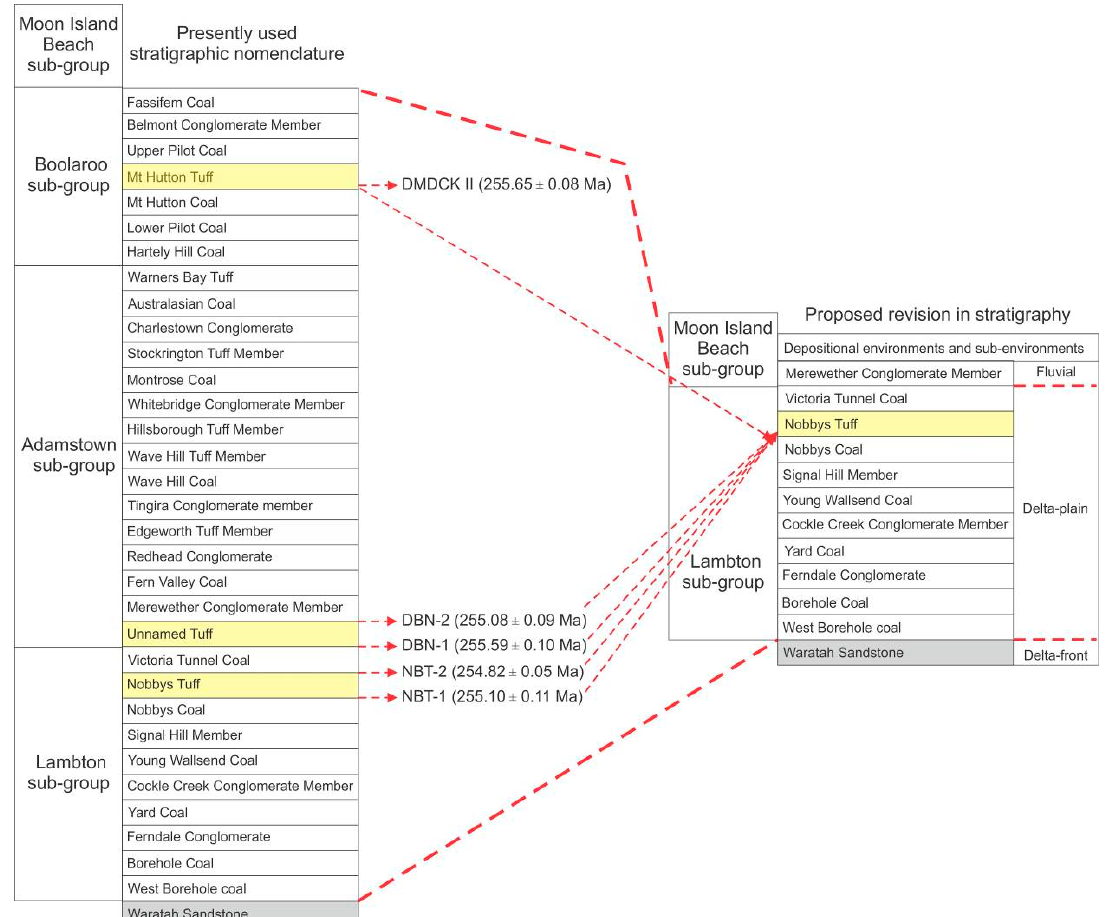
Figure 10. Comparable diagrams illustrating the differences between the current and the proposed revision of the stratigraphic framework in the NSB. Results from CA-IDTIMS dating and information about the depositional environments are included. The revised model amalgamates the regional stratigraphy and proposes the existence of two sub-groups: the Lambton sub-group that is represented by the deltaic setting, and the Moon Island Beach sub-group that includes (at least at its basal part) the fluvial portion of the succession. Further research is needed to accurately define the depositional settings that make up the remaining part of the Moon Island Beach sub-group.